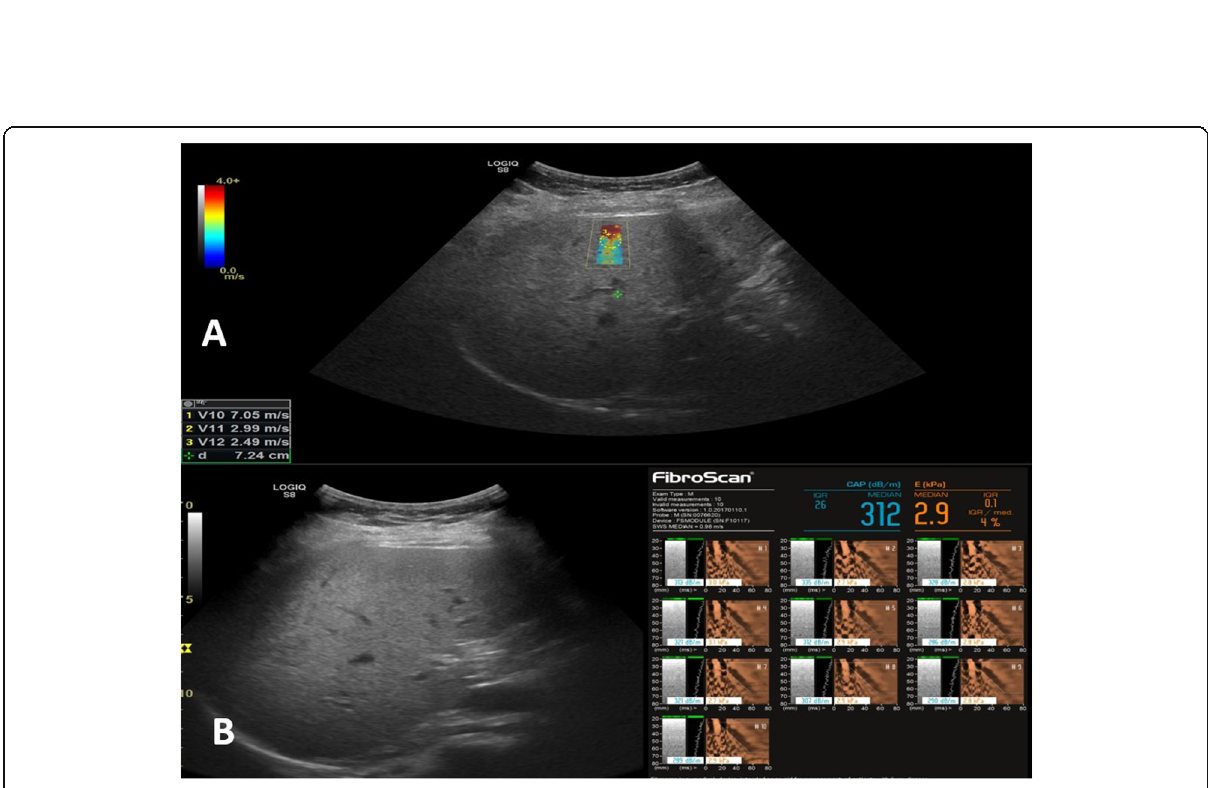
Fig. 5 A female patient 48 years old with chronic hepatitis B infection on follow-up. a SWE revealed median velocity = 1.54 m/s and V median/ IQR = 23% consistent with F2 according to Metavir score. b Fibroscan was done for the same patient and revealed kPa = 2.9 and IQR/median = 4% consistent with